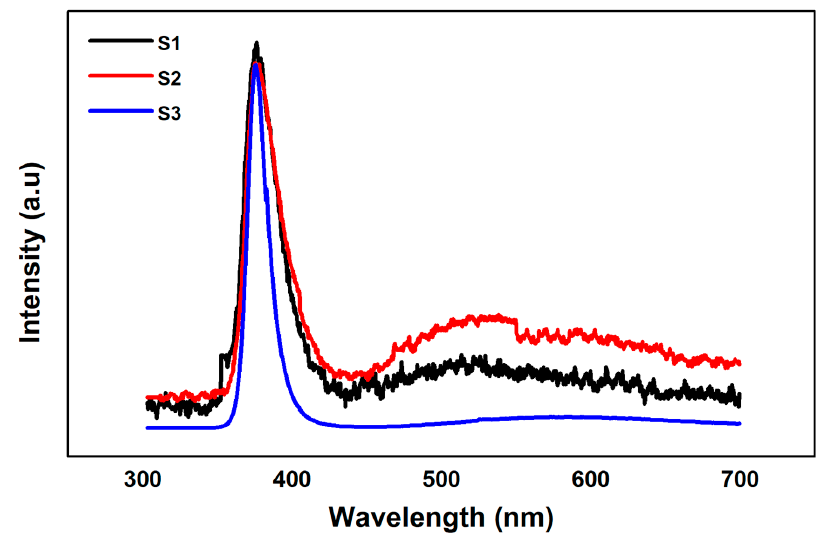
Figure 4 . Photoluminescence (PL) optical characteristics and defect analysis of S1, S2, and S3.